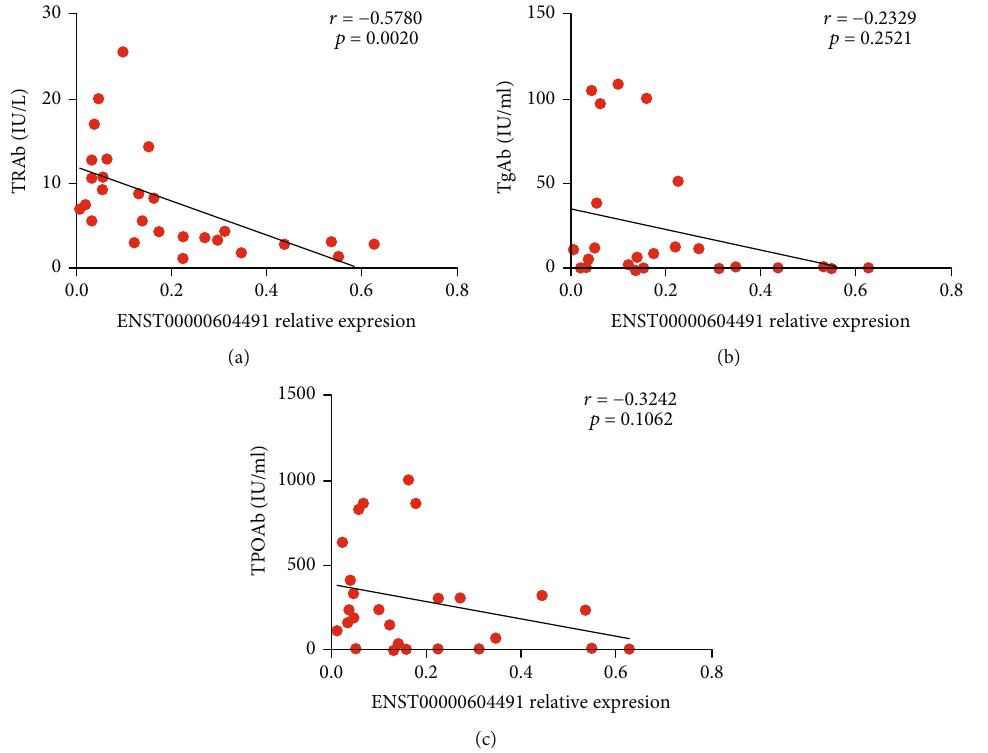
Figure 6: Correlation between ENST00000604491 expression and clinical indicators. The correlation between ENST00000604491 expression and serum levels of (a) TRAb, (b) TgAb, and (c) TPOAb in GD patients. Each data point represents an individual